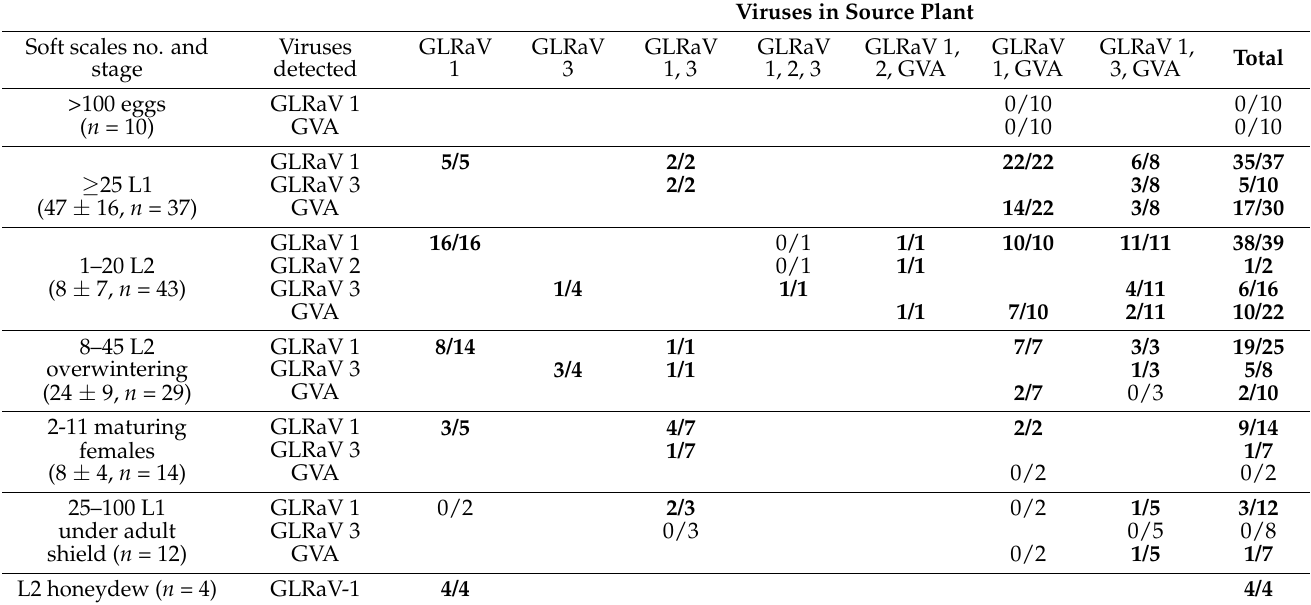
Table 3. Viruses detected by RT-PCR in Parthenolecanium corni nymph batches, according to their developmental stage and to virus associations in plant sources from vineyards prior to transmission experiments. Positive detection rates are highlighted in bold. For each stage, soft scale numbers with mean number ± sd per sample ( n